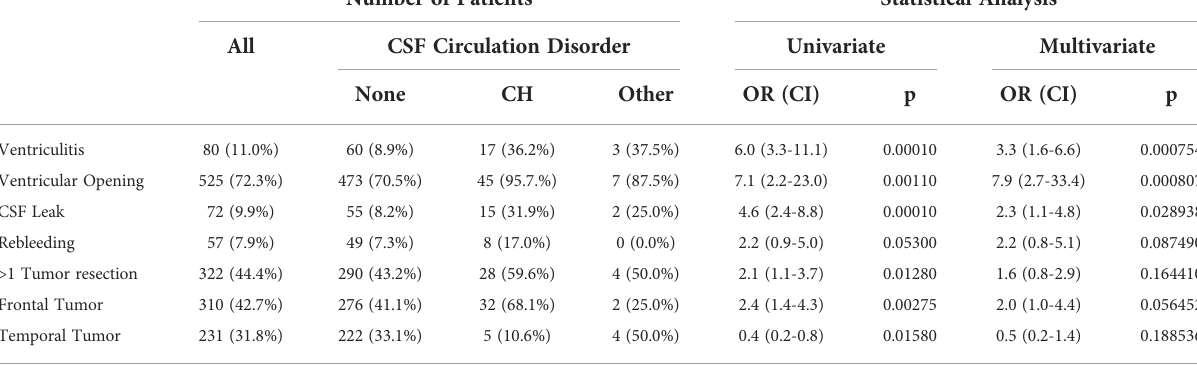
TABLE 2 Potential risk factors for the entire cohort and patients with different types of postoperative CSF circulation disorders (CH: communicative hydrocephalus; Other: obstructive hydrocephalus, hygroma, resection cavity